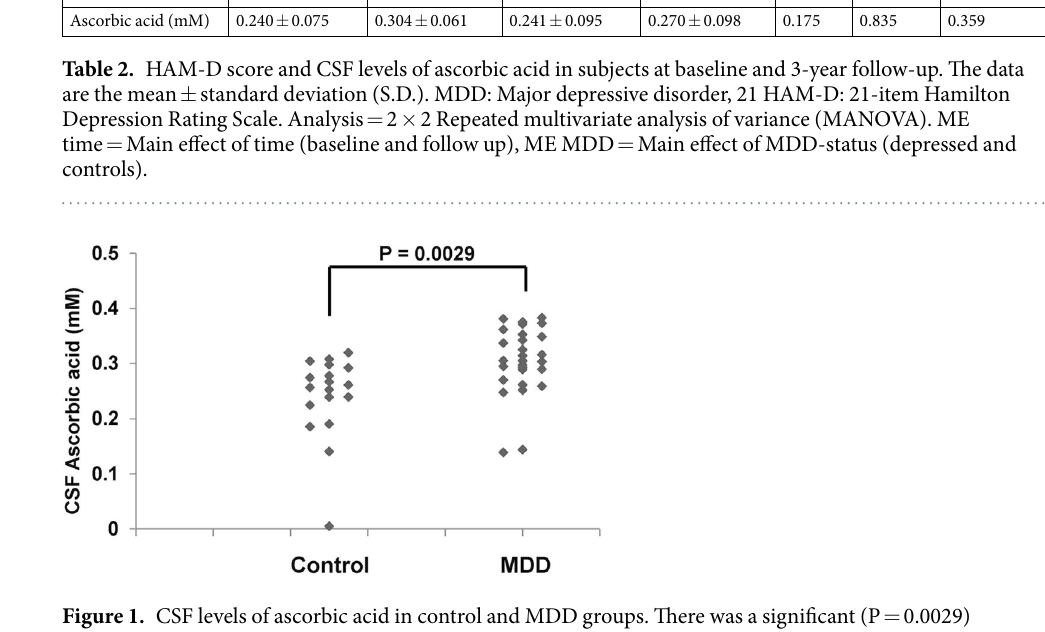
Figure 1. CSF levels of ascorbic acid in control and MDD groups. There was a significant (P = 0.0029) difference in CSF levels of ascorbic acid between the control groups (0.240 ± 0.075 mM, N = 18) and MDD (0.304 ± 0.061 mM, N = 28).